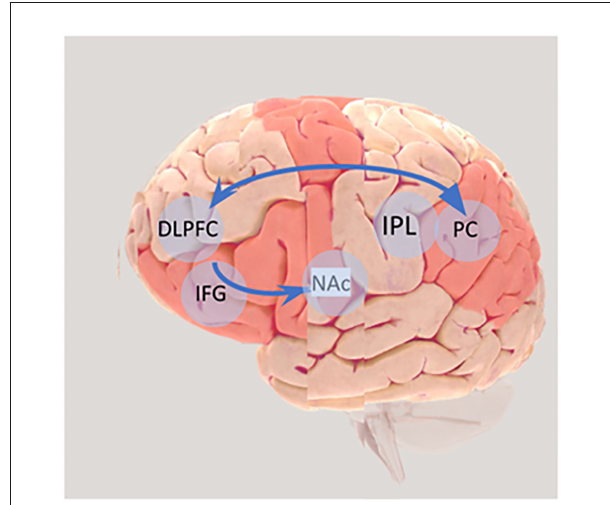
FIGURE1 The frontoparietal network, indicated by the arrow, extending from the dorsolateral frontal (DLPFC) cortex to the parietal cortex (PC) is a control hub involved in Systems Thinking (ST), observational learning. This region also overlaps with the putative mirror neuron system extending from the inferior frontal gyrus (IFG) to the inferior parietal lobule (IPL). The network between the DLPFC and nucleus accumbens (NAc) mediates reward processing and motivation which is important for observational learning. DLPFC is also linked with pro-environmental behaviour. Source: Image of Brain produced using 3D Brain